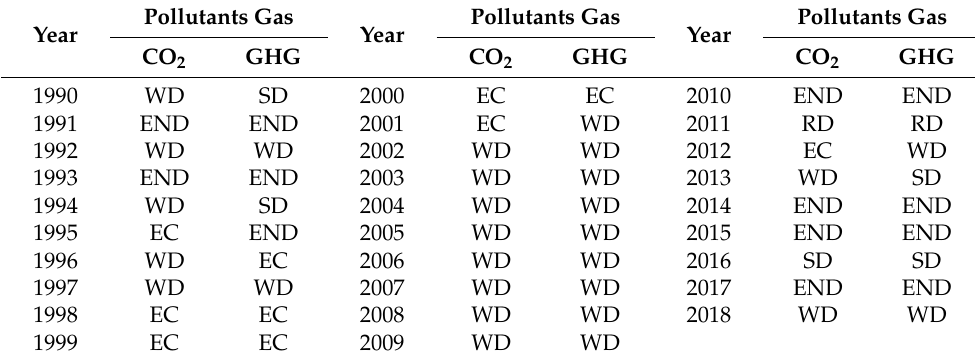
Table 5. Decoupling status of Tunisia’s economic growth.